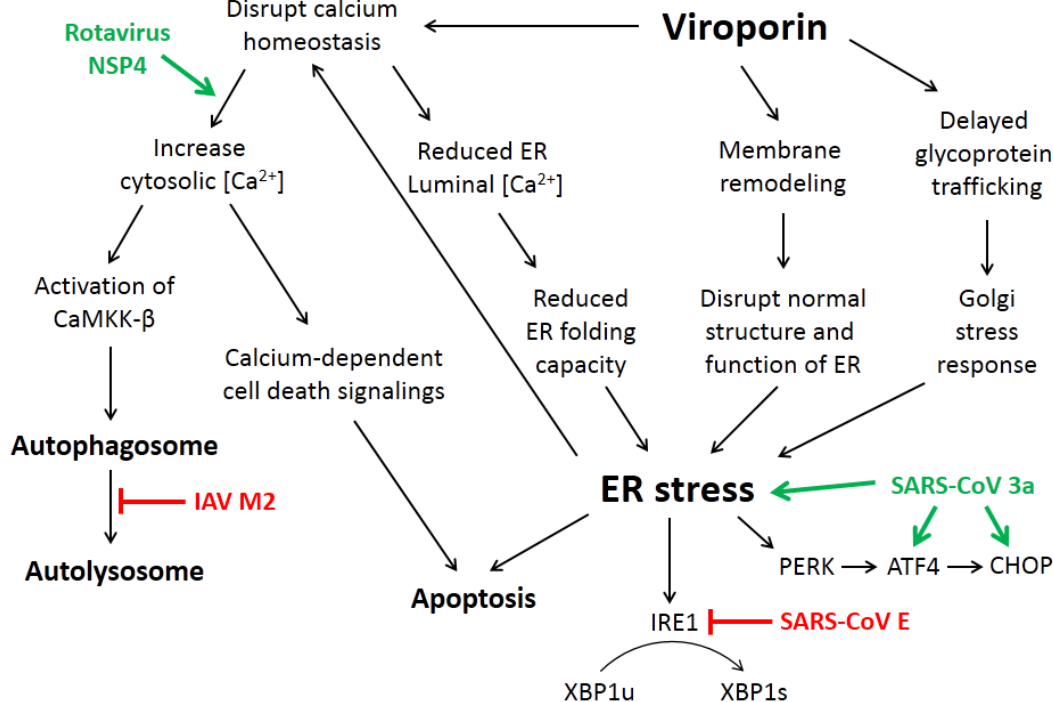
Figure 3. Mechanisms by which viroporins induce ER stress and autophagy. The ion channel